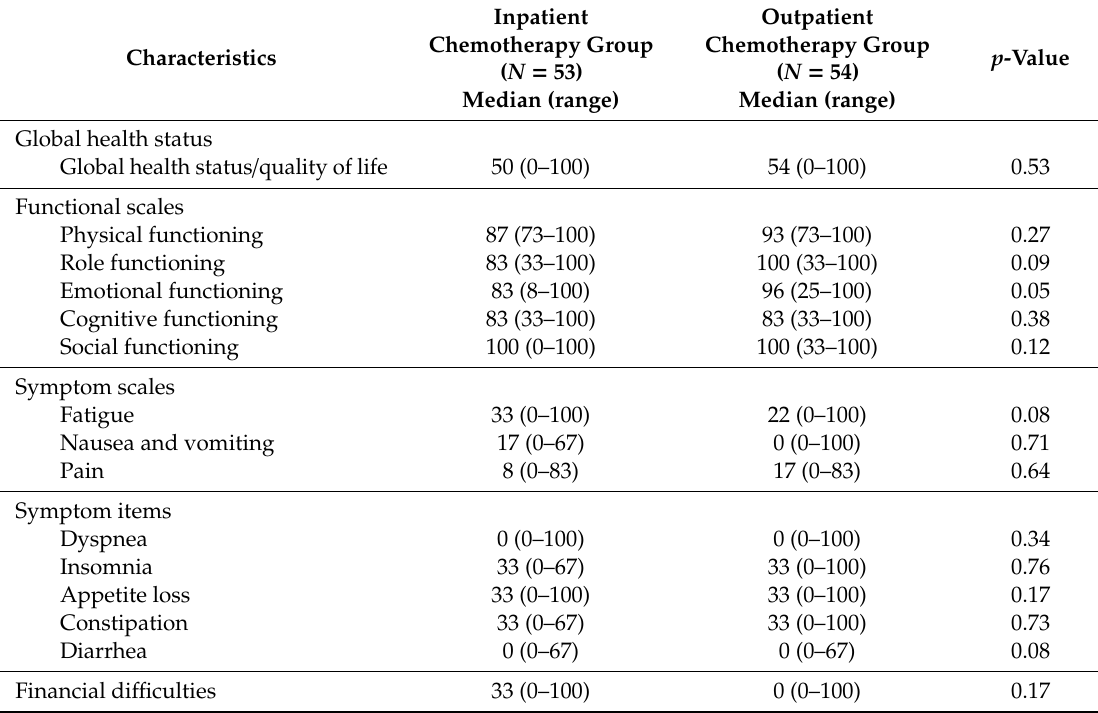
Table 2. EORTC-QLQ-C30 symptom scores.